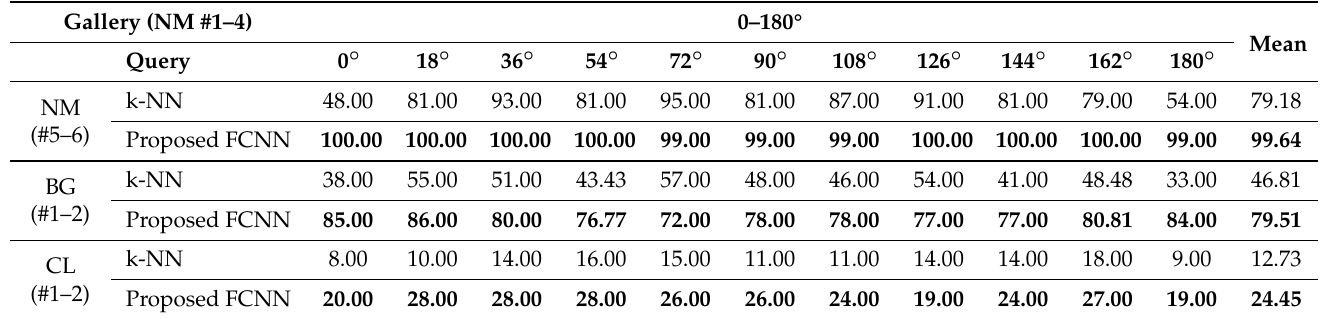
Table 6. Comparison of FCNN and k-NN classifiers accuracy on CASIA-B dataset using LT setting. The best results for each angle and overall are in